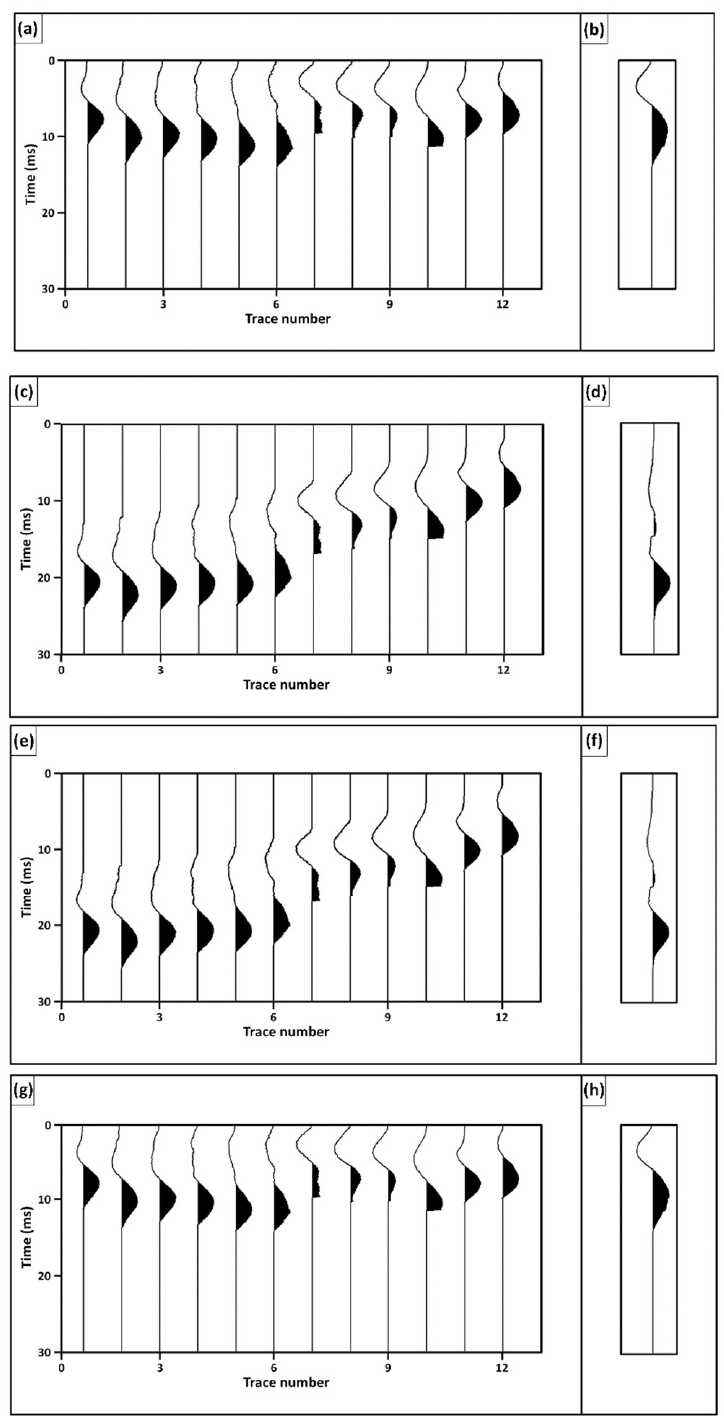
Figure 7. Trace wavelet responses (G) for: ( a ) ideal case; ( c ) perturbed case; ( e ) elevation error removal case; and ( g ) position error removal case. The corresponding array wavelet response of these cases are: ( b ) ideal case; ( d ) perturbed case; ( f ) elevation error removal case; and ( h ) position error removal case.